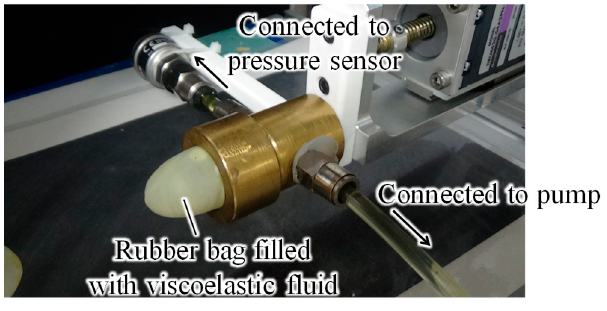
Figure 1. Fluid fingertip.